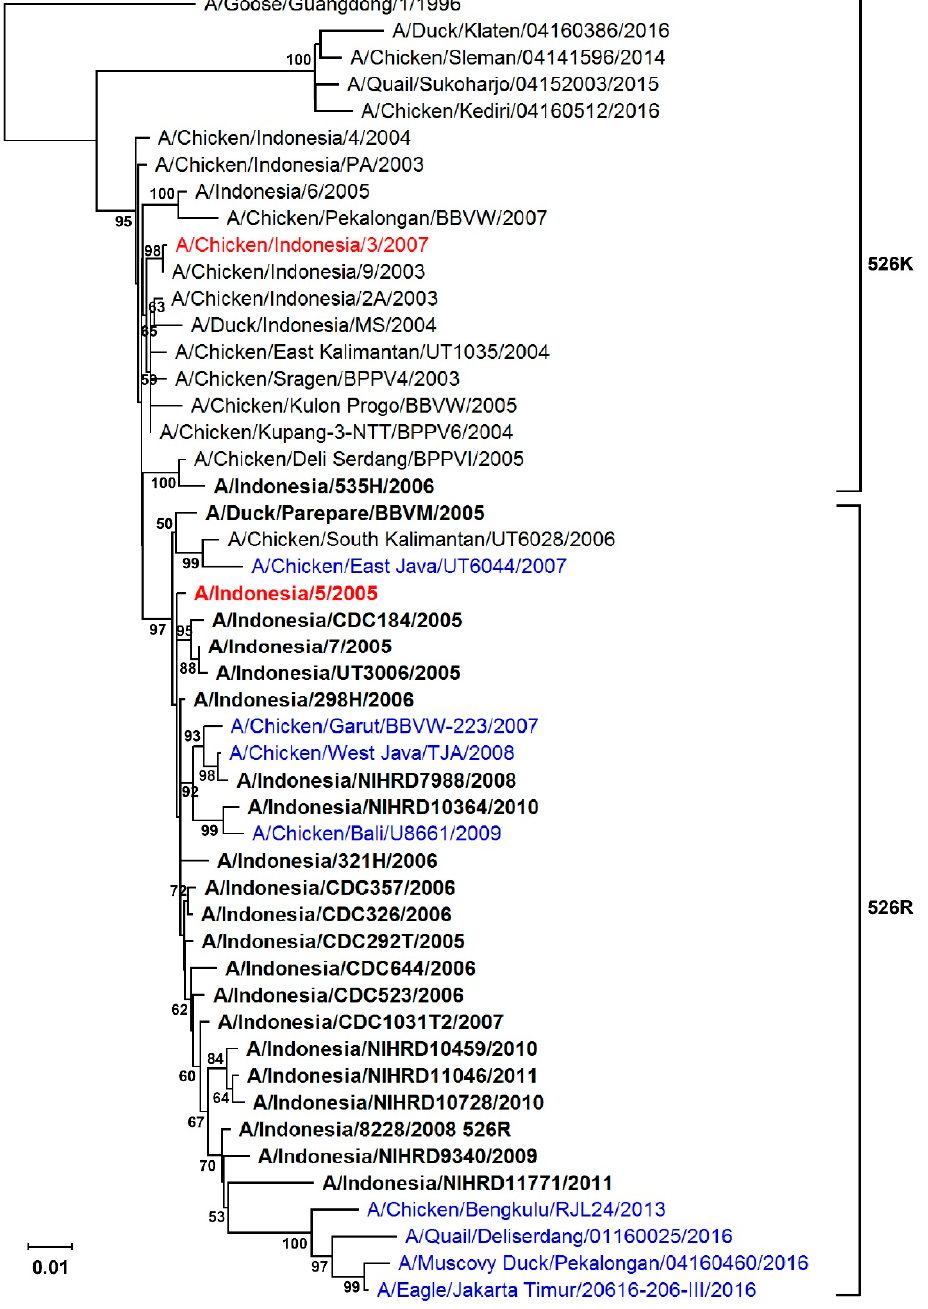
Figure 1. Phylogenetic tree of the PB2 gene of Indonesian H5N1 virus. The tree was constructed using the neighbor-joining method with the Tajima-Nei model of nucleotide substitution using MEGA X. Blue indicates avian strains carrying Arg at position 526 of the PB2 gene (526R). Human strains are highlighted in boldface. Numbers represent the bootstrap values (percentages) from 1000 replicates: only bootstrap values greater than 50 are shown. Strains in red are the avian isolate, A/Chicken/Indonesia/2A/2003 (CK2A), and the human isolate, A/Indonesia/5/2005 (IND5), used as backbones for constructing reverse genetic versions of viruses in this study.